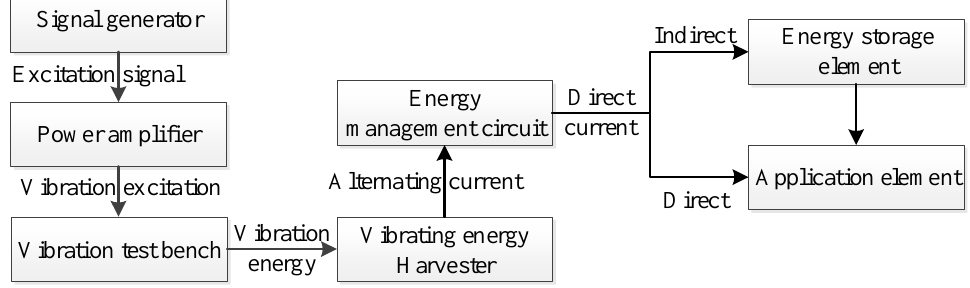
Figure 12. Energy harvester test platform. Table 3. Experimental materials and model structure parameters.